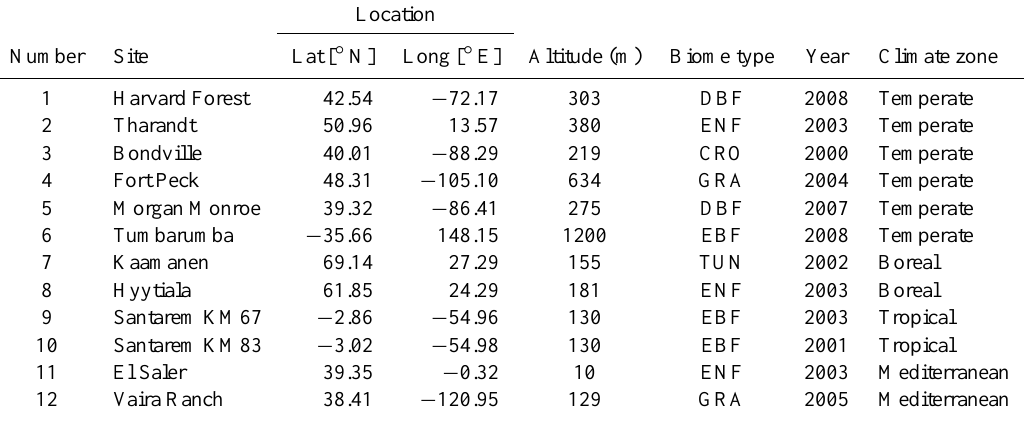
Table 2. Flux towers used in this study. The following biome types were used: deciduous broadleaf forest (DBF); evergreen needleleaf forest (ENF); cropland (CRO); grassland (GRA); tundra (TUN); evergreen broadleaf forest (EBF).